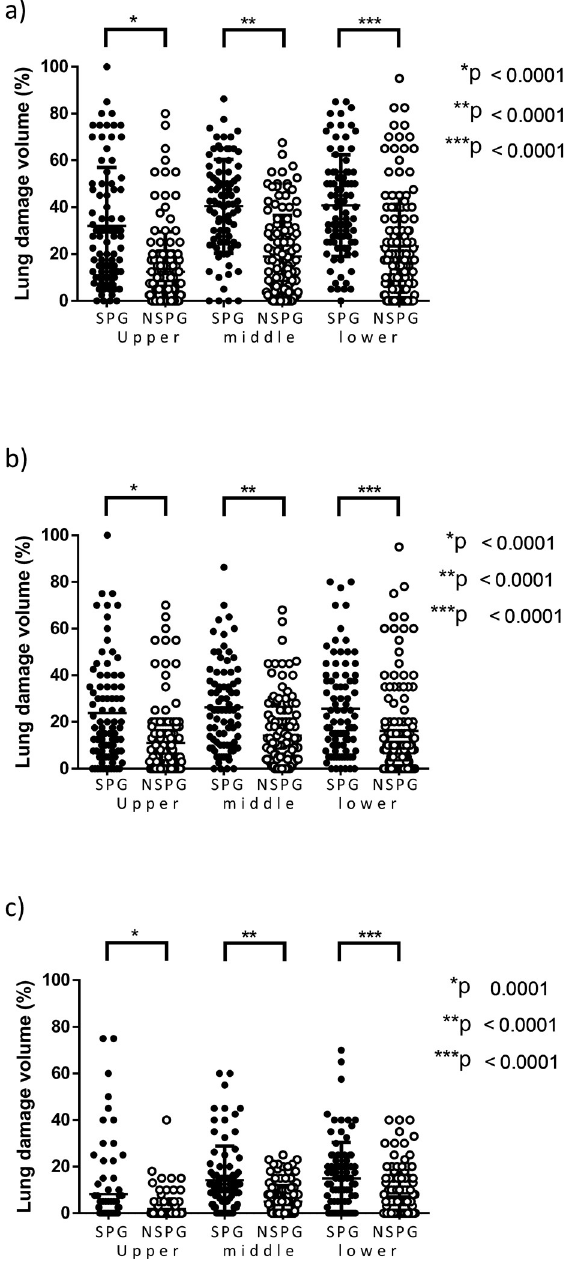
Fig 3. Comparison of the extent of lung damage according to regions. a) Overall combining GGO and consolidation. b) GGO. c)